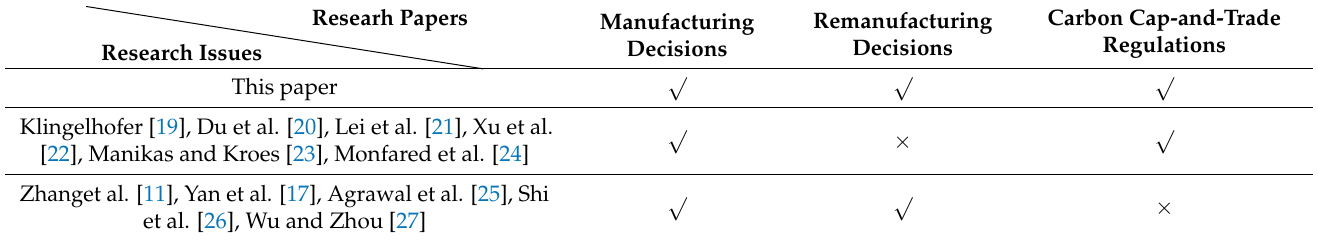
Table 1. Contributions compared to existing literature.